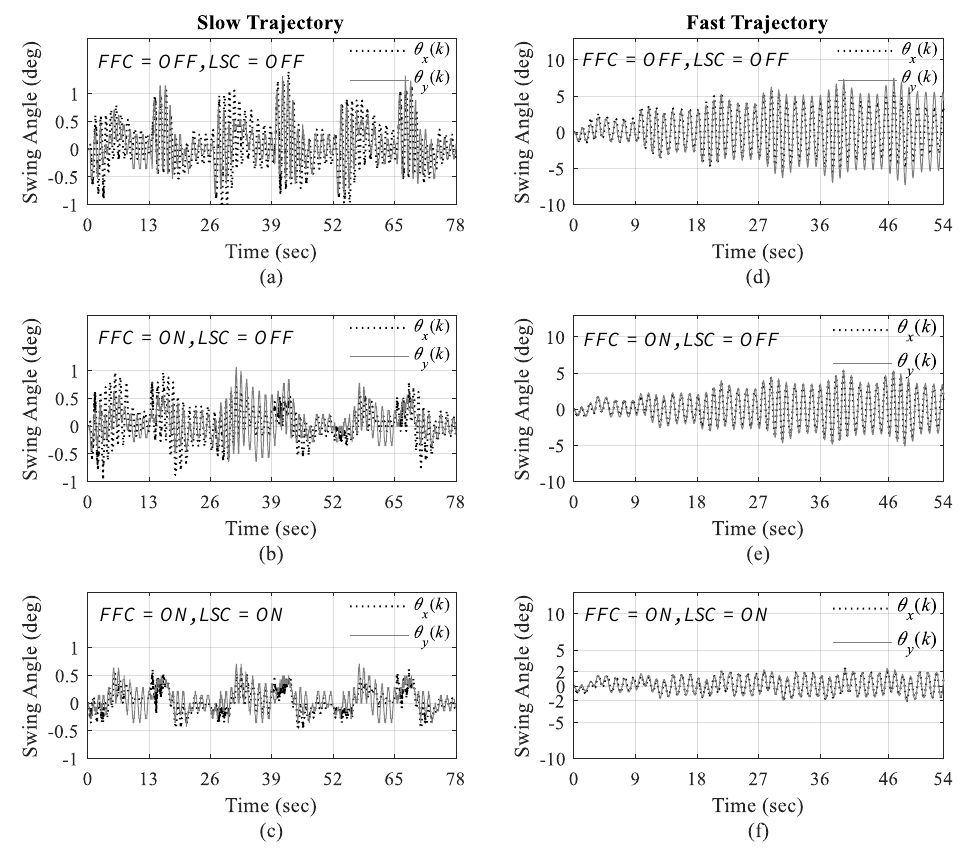
Figure 11. Load swing in X and Y directions for slow trajectory in ( a ) 1st; ( b ) 2nd; ( c ) 3rd Scenarios and for fast trajectory in ( d ) 1st; ( e ) 2nd, and ( f ) 3rd Scenarios.